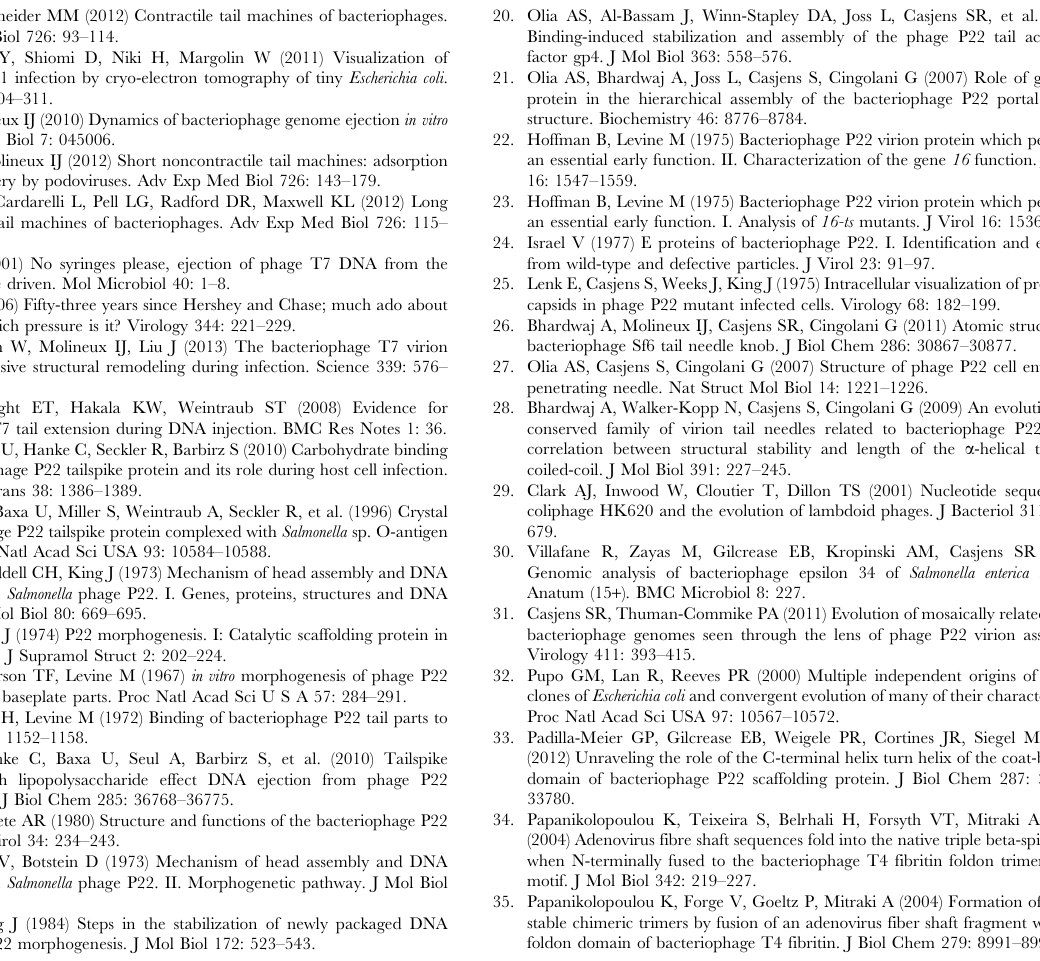
Figure S2 Relationships among the phage Sf6 type tail needle C-terminal domains of the P22-like phages. (PDF) Figure S3 Conserved residues in Sf6 tail needle knob-like proteins. (PDF) Figure S4 The hybrid P22:HS1-1 hybrid needle is incorporated into the virion. (PDF) Table S1 Oligonucleotides used in this